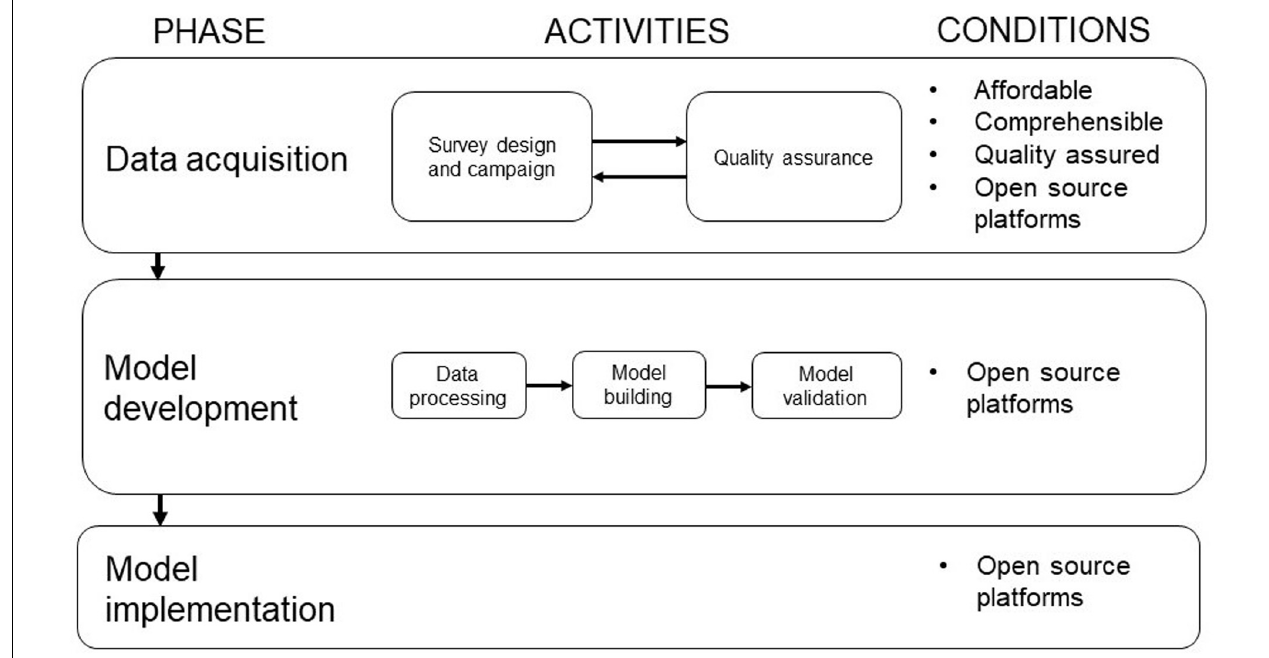
FIGURE 1 | A framework for flood modeling with community mapped